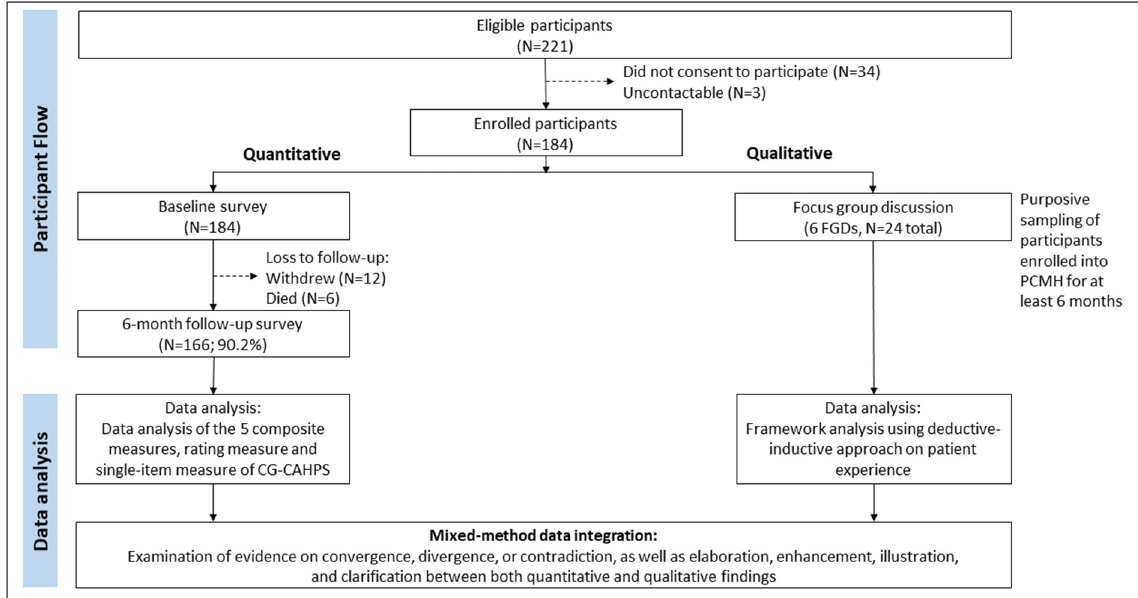
Figure 2. Participant Flow and Data